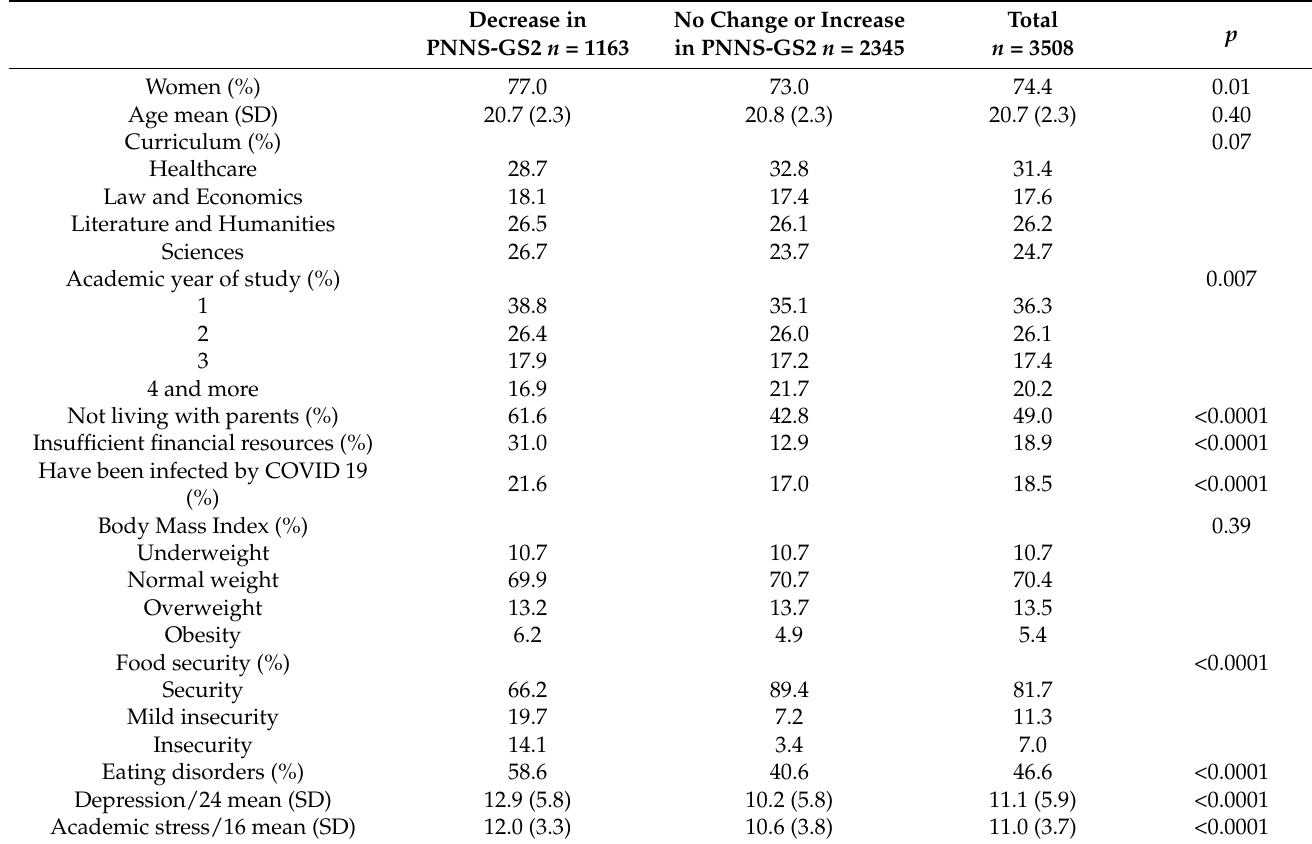
Table 2. Characteristics of the university students according to the change of the PNNS-GS2 ( n =